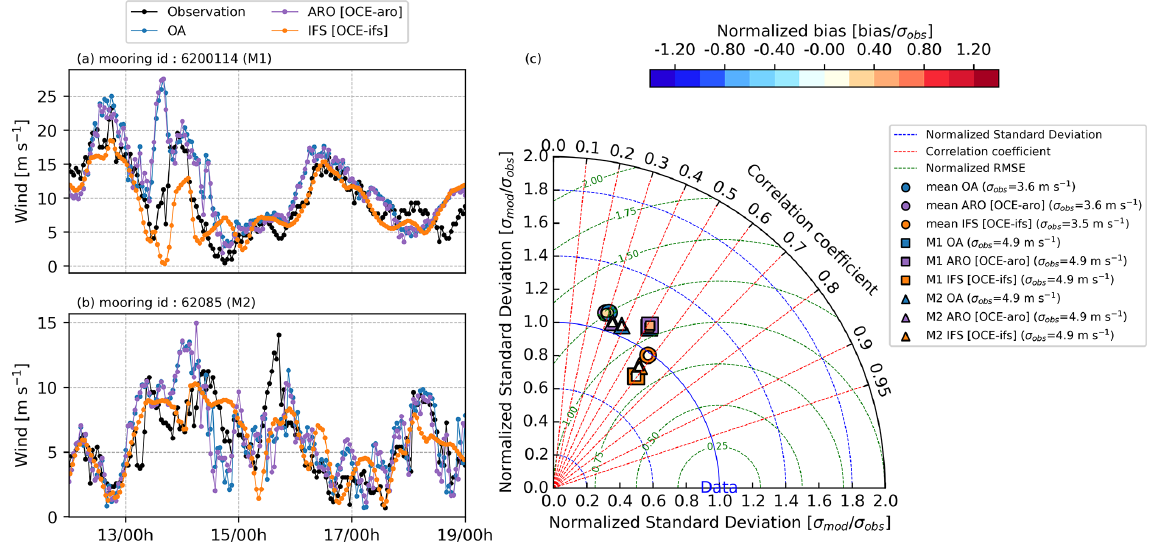
Figure 12. Temporal evolution of 10m wind speed observed and simulated at the location of two moorings M1 (a) and M2 (b) (see Fig. 11a for locations). (c) Taylor diagrams made for the whole dataset of 44 selected moorings are shown as circles. Moorings M1 and M2 only are shown as squares and triangles respectively. The external colour indicates the experiment: blue for OA, purple for ARO (OCE-aro) and orange for IFS (OCE-ifs).